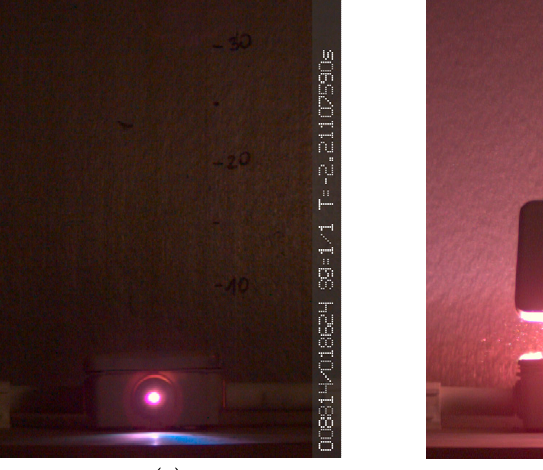
Figure 9. Development of the arc discharge for three successive ignitions of the electric arc: ( a ) first ignition of the electric arc t 1 = 0 ms, ( b ) second ignition of the electric arc t 2 = 6.25 ms, ( c ) third ignition of the electric arc t 3 = 17.4 ms ( I m = 1250 A, U = 400 V, Al-Al electrodes).